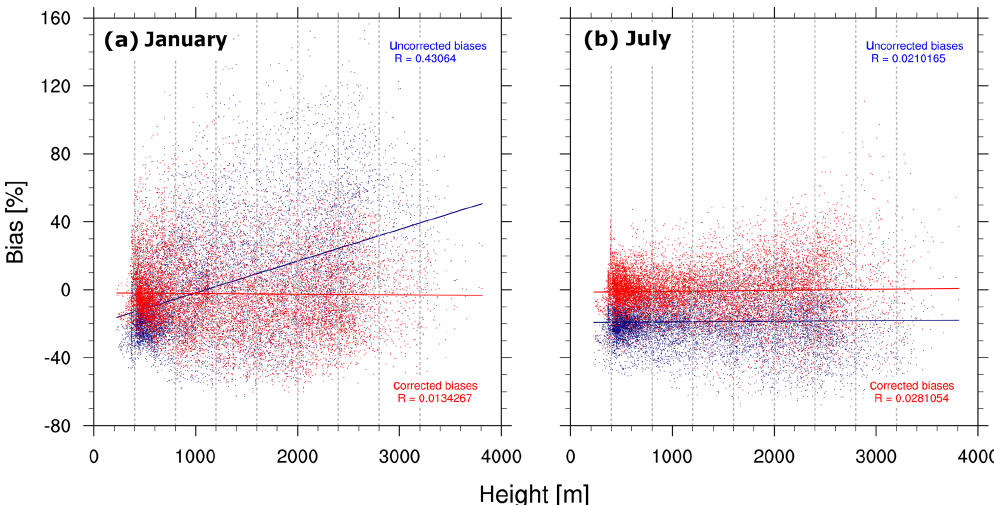
Figure 6. Biases over Switzerland. Blue (red) indicates the original (corrected) biases. Panel (a) illustrates the bias versus height at each grid point during January; panel (b) is the same as (a) but for July. Solid lines represent the linear regressions, R the correlation between biases and height, and vertical dashed grey lines the boundaries of the height classes.